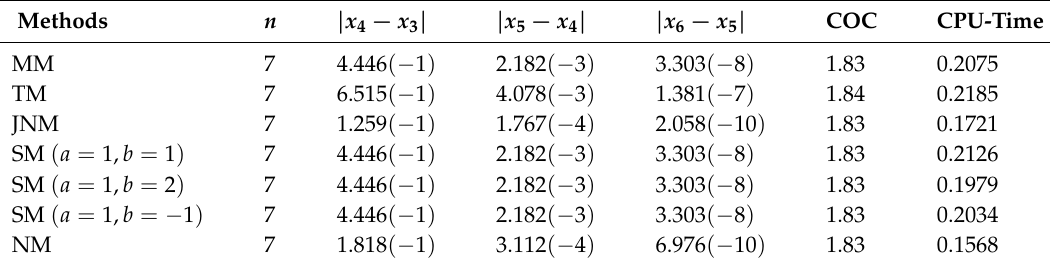
Table 3. Comparison of performance of methods for function f 3 ( x ) , taking x 0 = 430, x 1 = 200, x 2 =